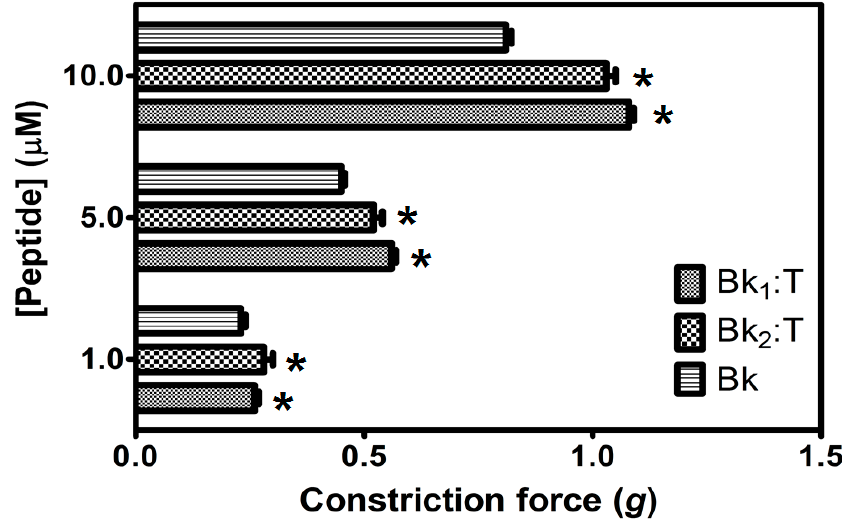
Figure 7. Smooth-muscle constriction force assay of Bk 1 and Bk 2 in different concentrations (1.0, 5.0 and 10.0 μ M), in guinea pig ileum smooth-muscle. * p < 0.05 is compared with all other peptides at the same